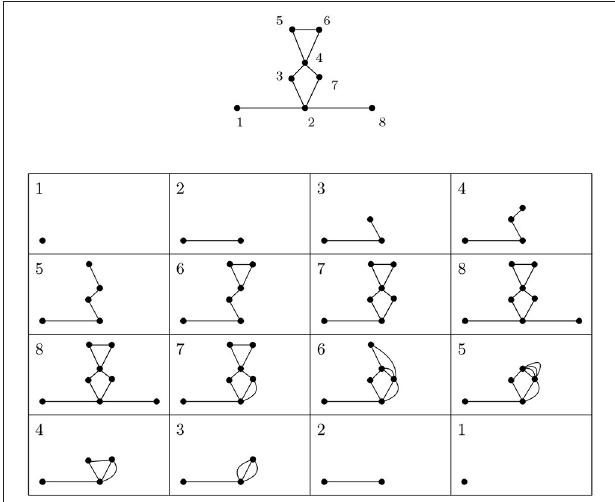
FIGURE 3 | A depiction of a simplicial complex with a filtering function (numbers next to vertices) and of spaces that appear in extended persistence. There are two loops of extended type—the first present over [6 , 4) and the other over [7 , 2) . We interpret this as follows: in this simplicial complex there is one loop that begins to form at 2 and is completed at 7 and another completed at 6 whose first edge appears at 4.